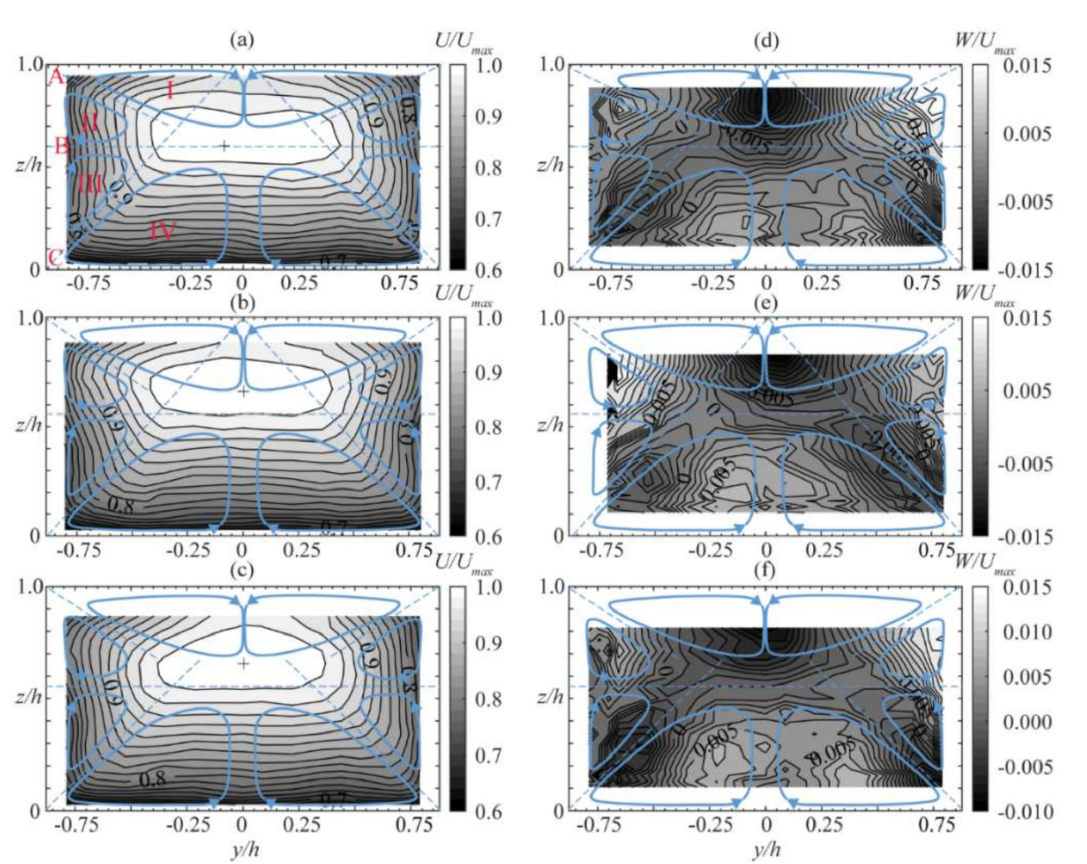
Figure 2. Contour plots of mean normalized flow velocities in ( a – c ) streamwise direction, ( d – f ) vertical direction for TA1–TA3. In ( a ) I = free-surface vortex, II and III = mid vortices, IV = bottom vortex, A = surface corner bisector, B = mid-bisector, C = bottom corner